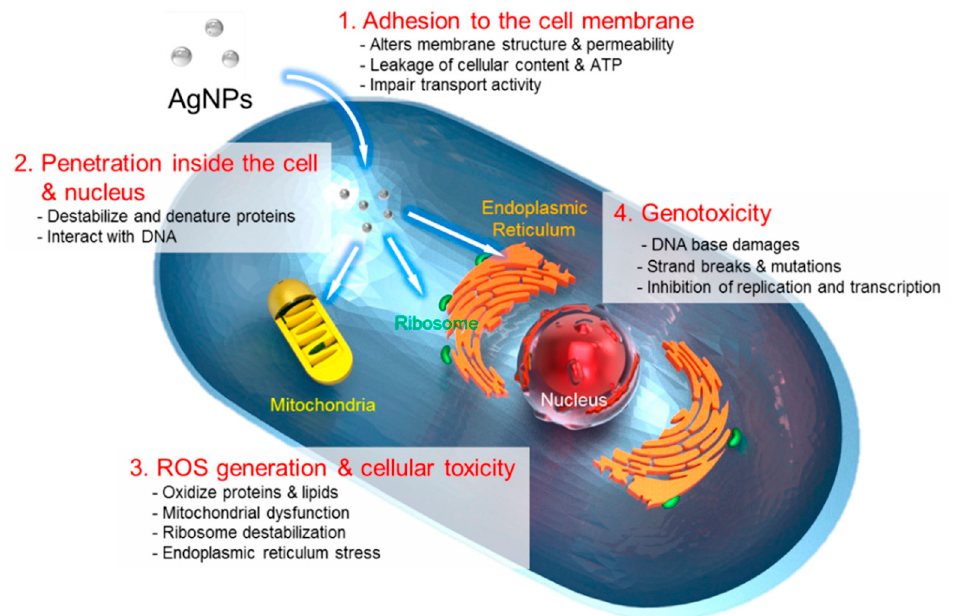
Figure 5. The four main routes of the cytotoxic mechanism of AgNPs. 1: AgNPs adhere to the surface of a cell, damaging its membrane and altering the transport activity; 2: AgNPs and Ag ions penetrate inside the cell and interact with numerous cellular organelles and biomolecules, which can affect corresponding cellular functions; 3: AgNPs and Ag ions participate in the generation of reactive oxygen species (ROS) inside the cell, leading to cell damage; and 4: AgNPs and Ag ions induce the genotoxicity. (Reprinted from [81], license CC BY 4.0.)